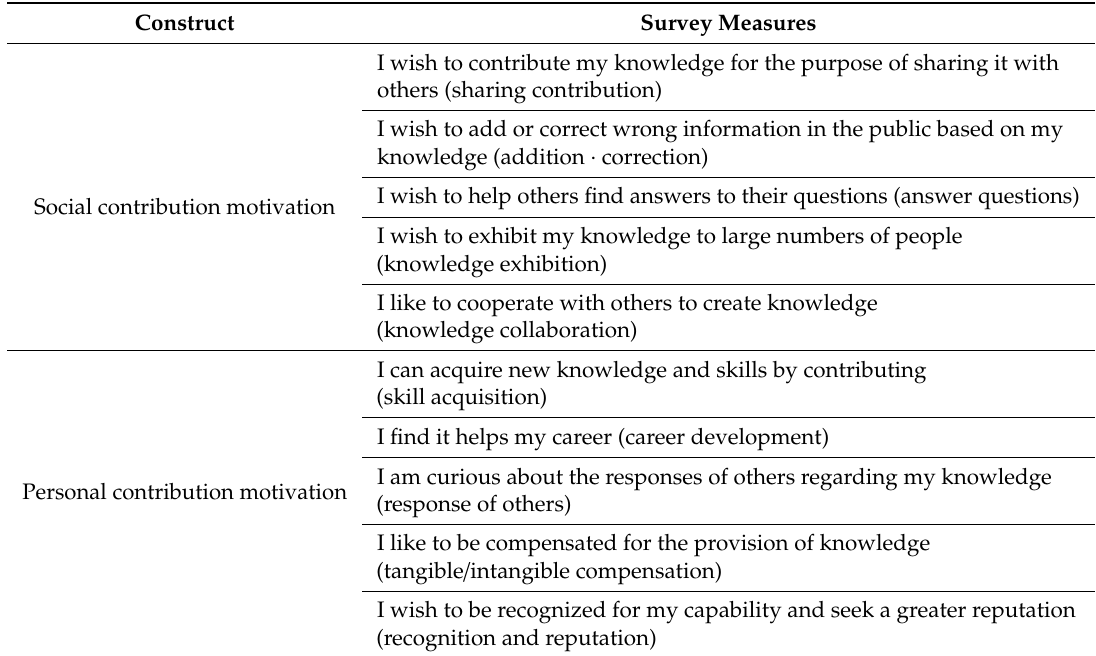
Table 2. Statistics of construct